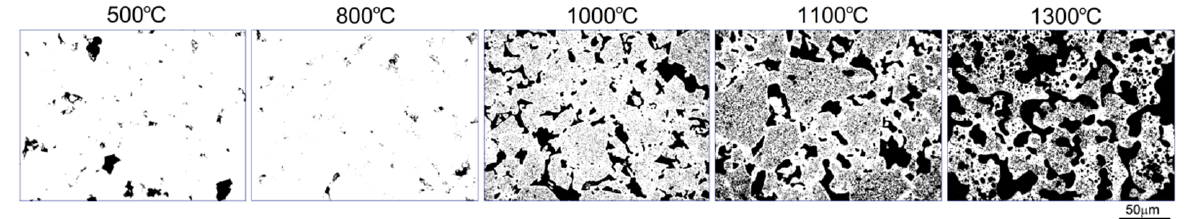
Figure 2. Scheme of Ti20Nb5Zr-Mg thermal dealloying process—optical micrographs at various stages.